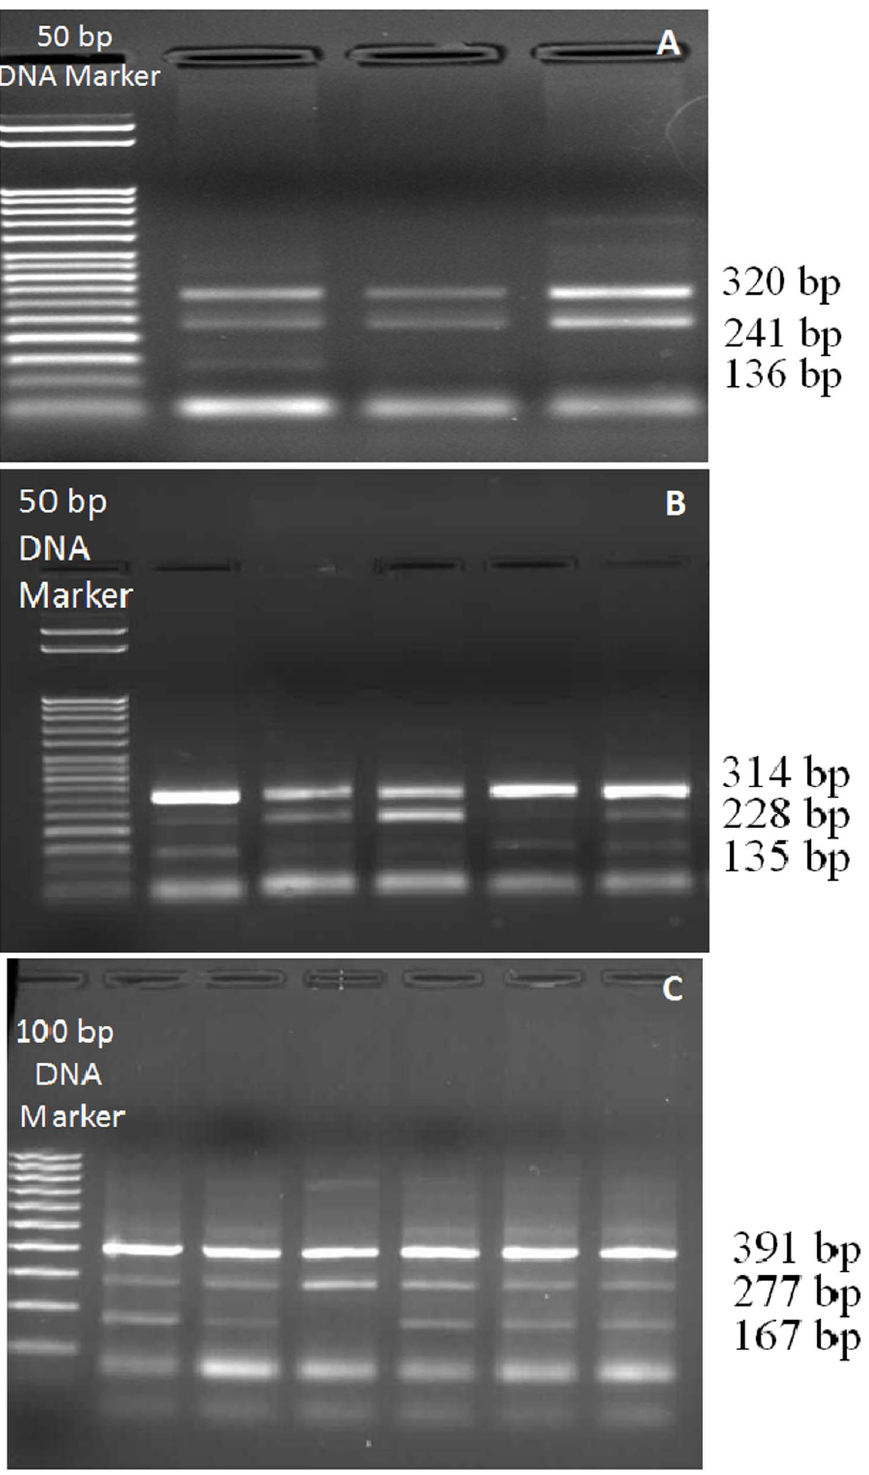
Figure 1. Representative gel images showing of each SIRT1 gene polymorphisms; A. rs7895833 containing a 50 bp DNA ladder in the first lane. B. rs2273773 containing a 50 bp DNA ladder in the first lane. C. rs7069102 containing a 100 bp DNA ladder in the first lane.